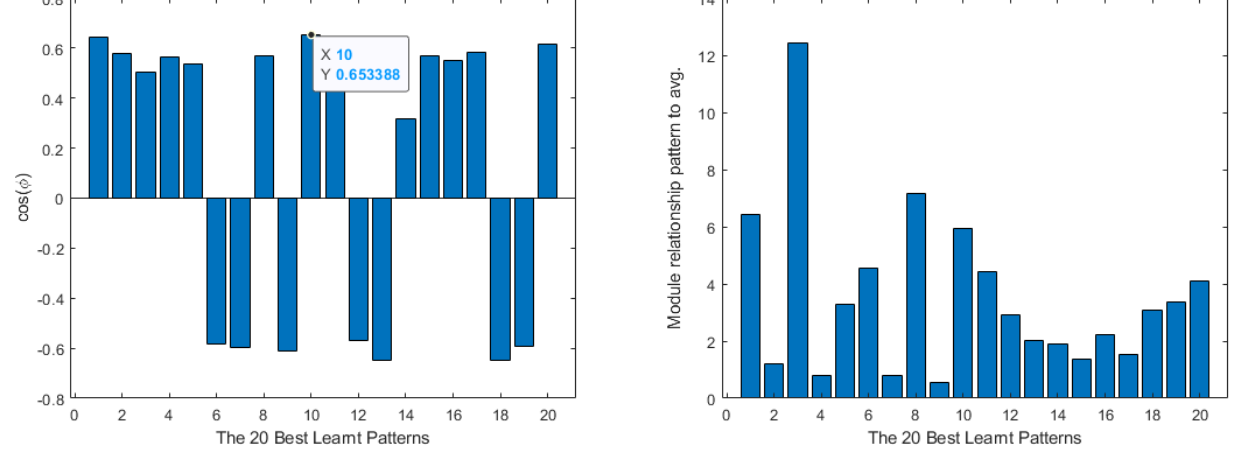
(cid:12) (cid:12) 𝜕𝐿𝑜𝑠𝑠 ∂ Loss (cid:12) (cid:12) | relationship to the average (cid:12) (cid:12) relationship to the average ∂ W n 𝜕𝑊 𝑛